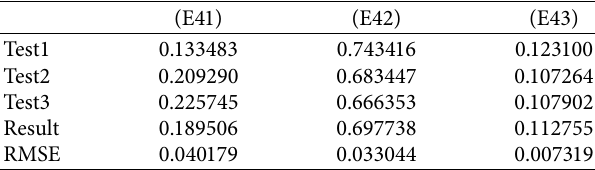
Figure 13: Proportion of each index of vehicle entry section. Table 6: Evaluation results of vehicles leaving the road section.